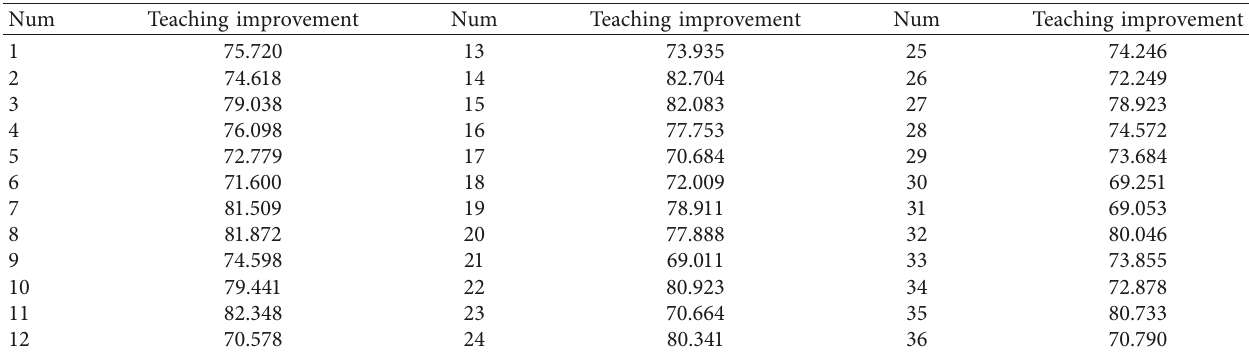
Table 2: The improvement effect of college English teaching based on VR technology and AI technology.